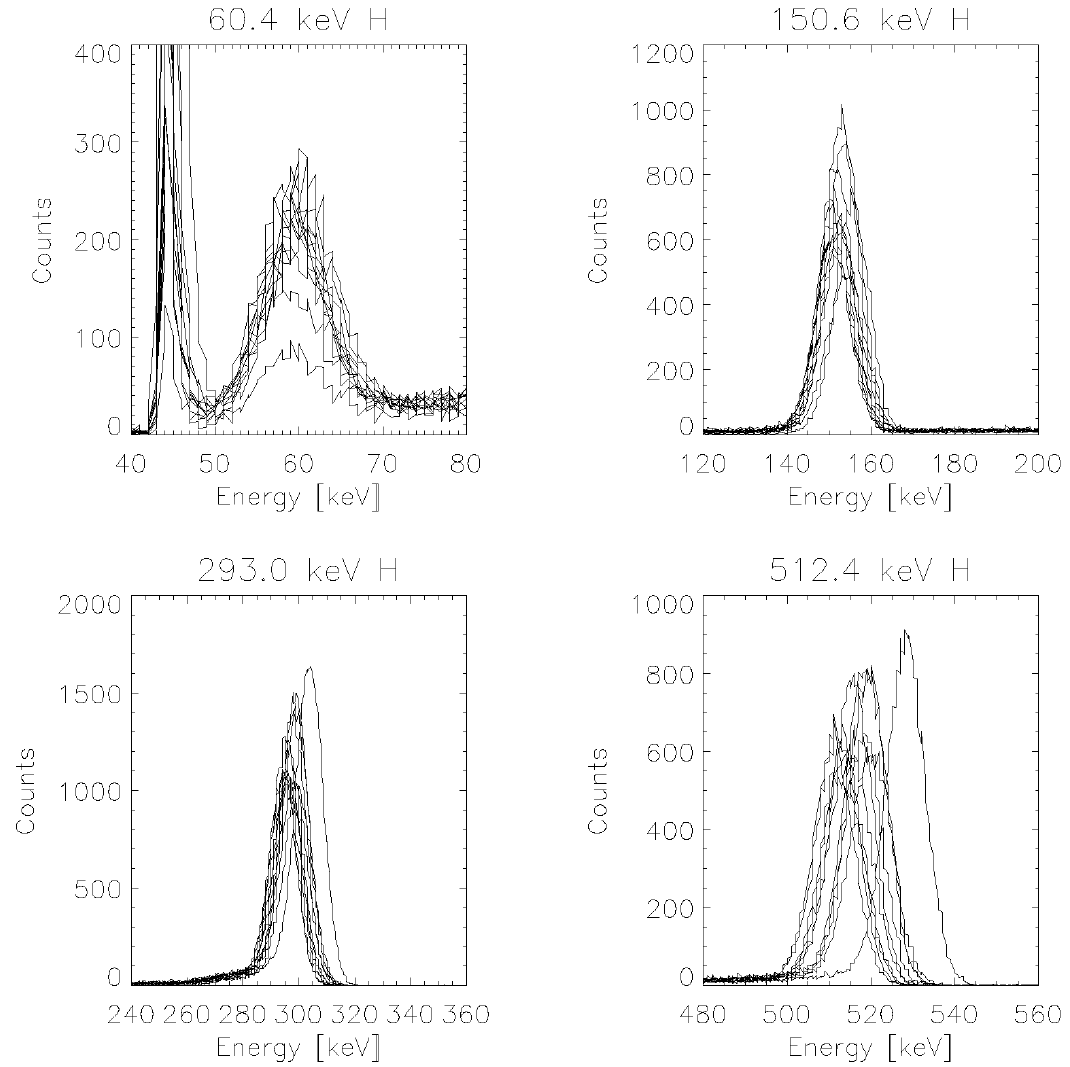
Fig. 7. Responses of all the detectors to hydrogen neutral atom beams of different energies (60.4, 150.6, 293.0 and 512.4keV, respectively).